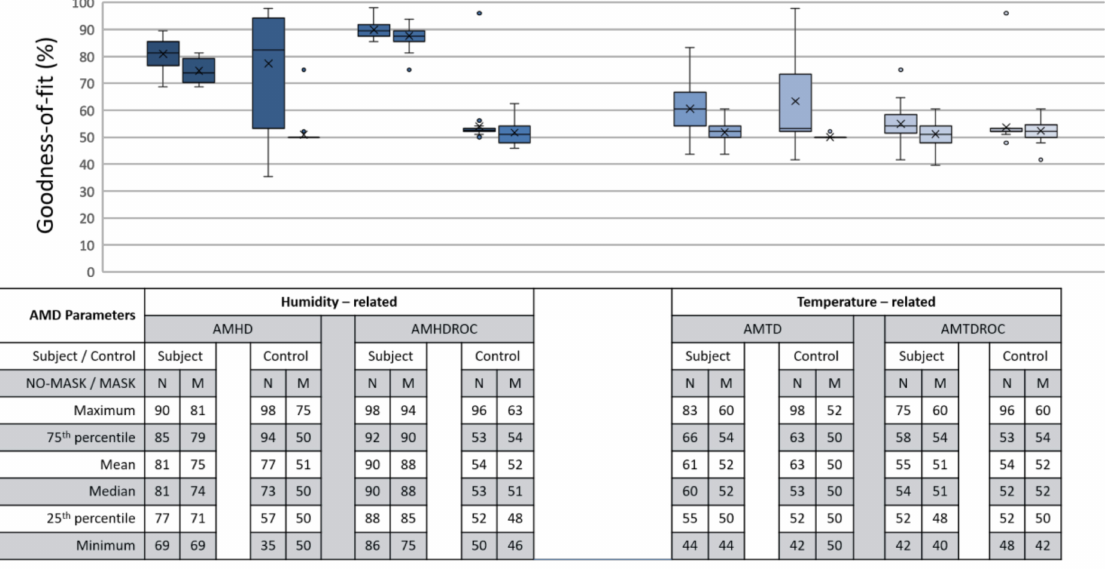
Figure 14. Goodness of fit distribution between subject (S) and control (C) groups in LR modelling represented in percentages. Each box contains 30 respective entries. AMHD (leftmost) has a mean of ~80% under N condition and ~75% under M